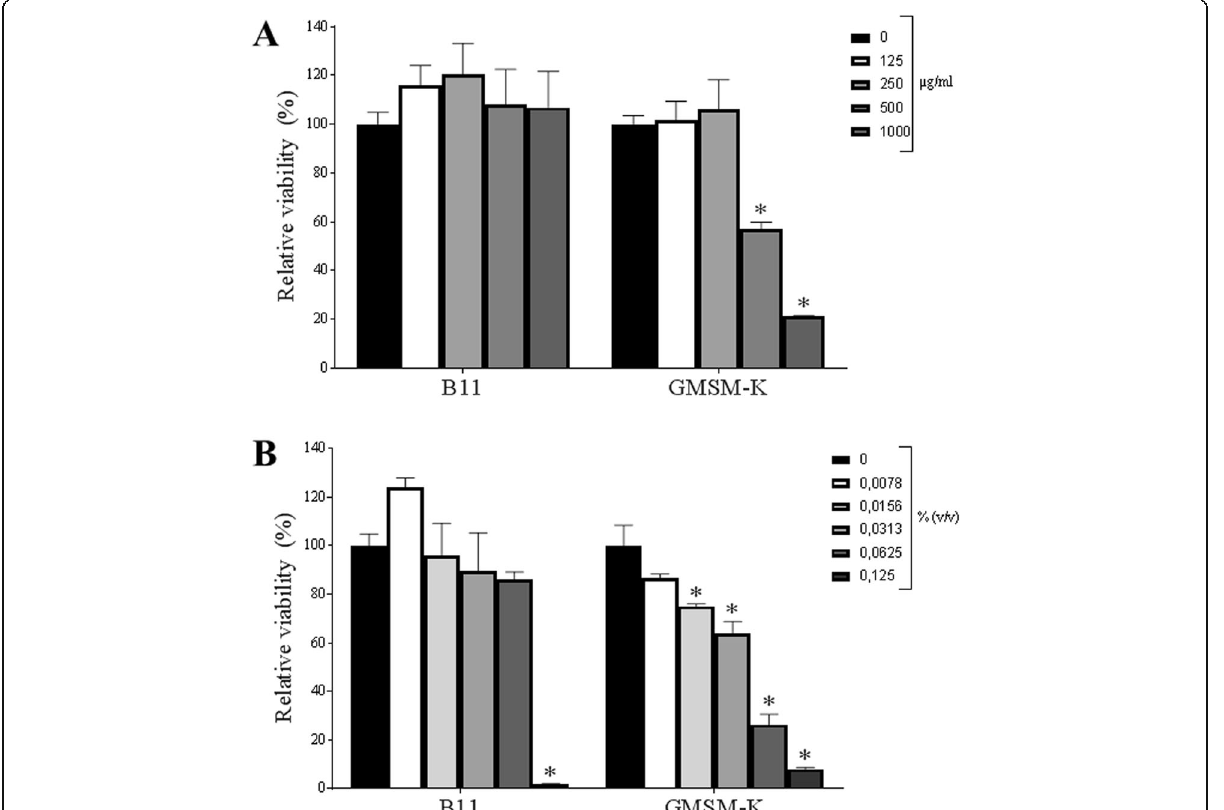
Fig. 6 Effect of Cinnulin PF® (panel a ) and cinnamon bark oil (panel b ) on the viability of two oral epithelial cell lines (B11 and GMSM-K). The epithelial cells were treated for 16 h with the cinnamon fractions prior to determining cell viability using a colorimetric MTT assay. Results are expressed as the means ± SD of triplicate assays in two independent experiments. *: significantly different from the control ( p <